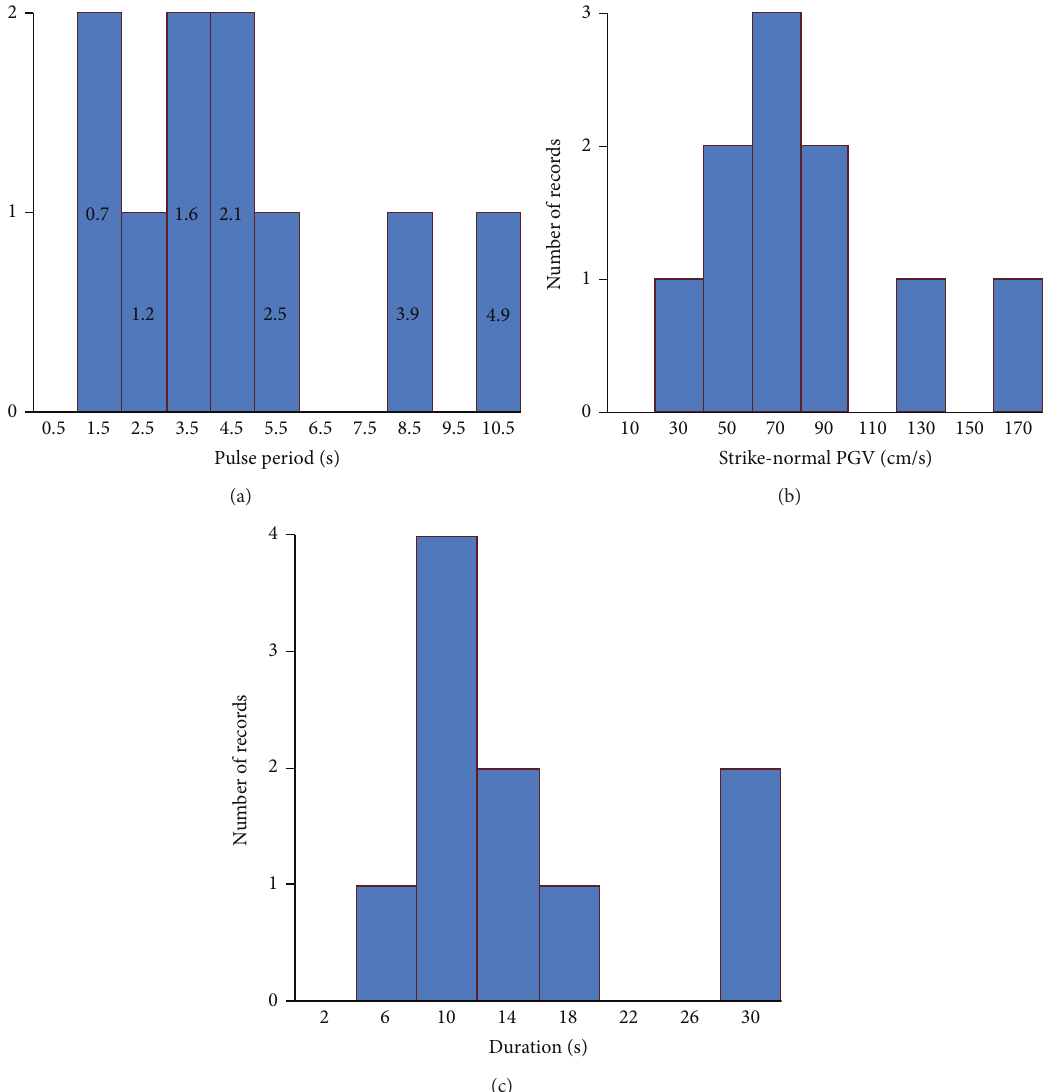
Figure 2: Histogram of (a) pulse periods. (The ratio of pulse period to fundamental period of JTOP is labeled on the histogram.) (b) Strike- normal peak ground velocities. (c) Significant duration (2.5% to 97.5% AI) of selected